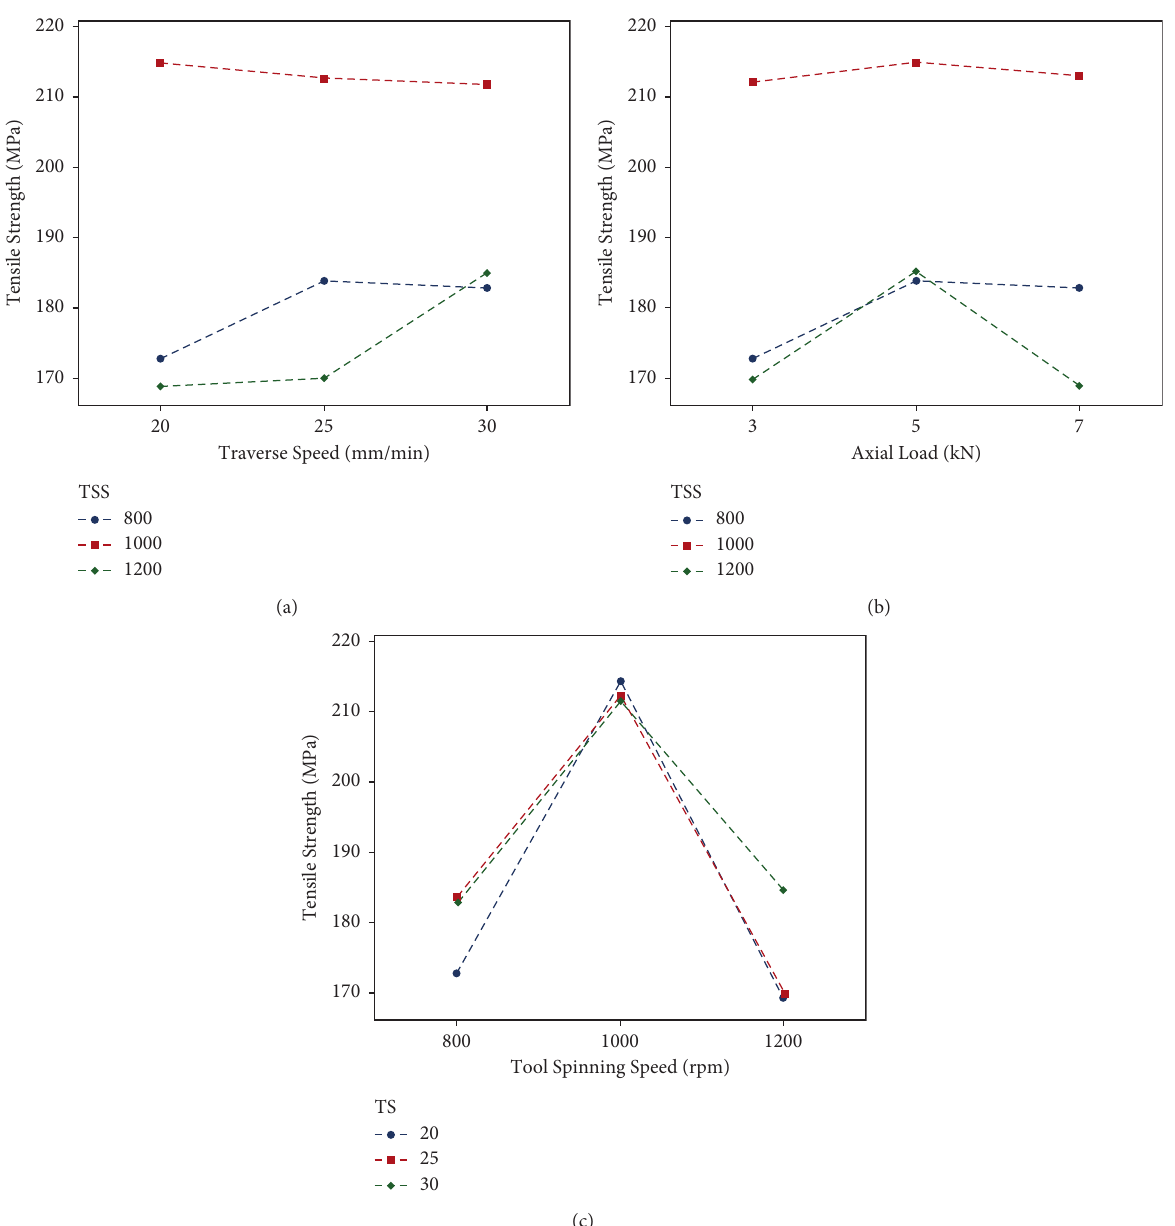
Figure 4: Interaction plots of tensile strength for (a) tool spinning speed versus traverse speed, (b) tool spinning speed versus axial load, and (c) traverse speed versus tool spinning